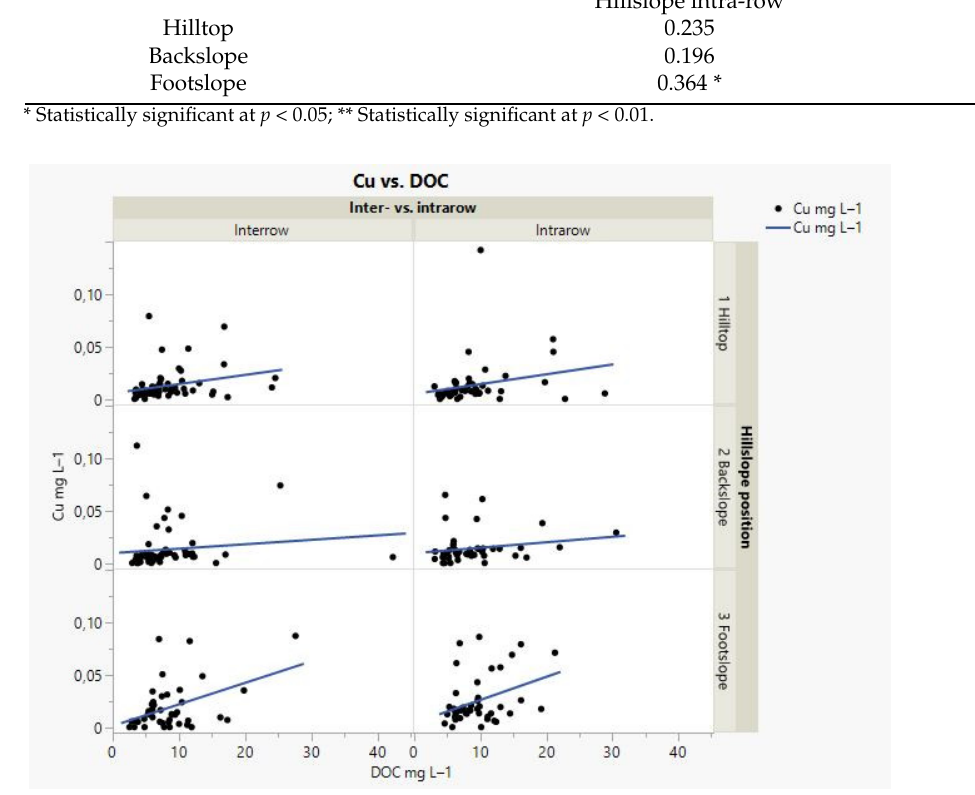
Table 3. Correlations between copper and dissolved organic carbon concentrations in leachates col- lected monthly for two years (2 November 2020–25 November 2022) from lysimeters installed at the hilltop, backslope and footslope of the vineyard inter- and intra-row. Position on the Slope Pearson Correlation Coefficients for Cu × DOC Correlation